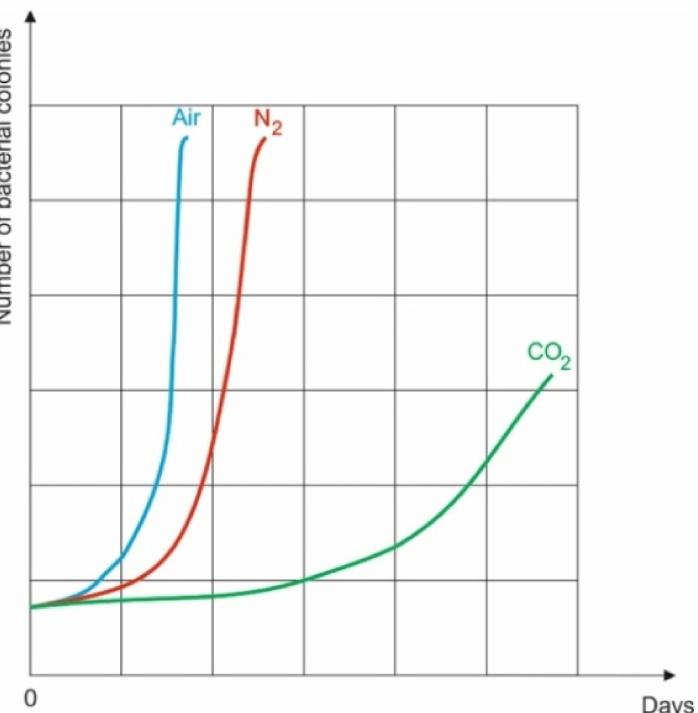
Figure 2. Bacterial colony numbers increasing on pork with or without MAP gases in stable low temperature (3–5 ◦ C), reprinted with permission from WITT